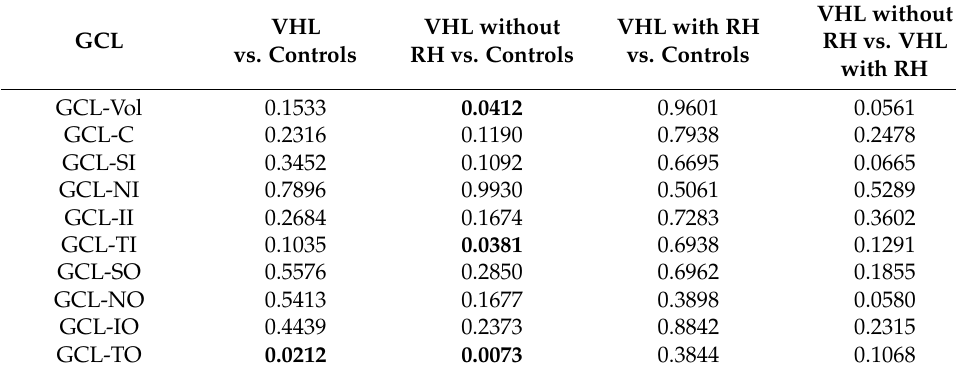
Table 7. Statistical significance ( p -value) of GCL thickness in the analyzed groups.